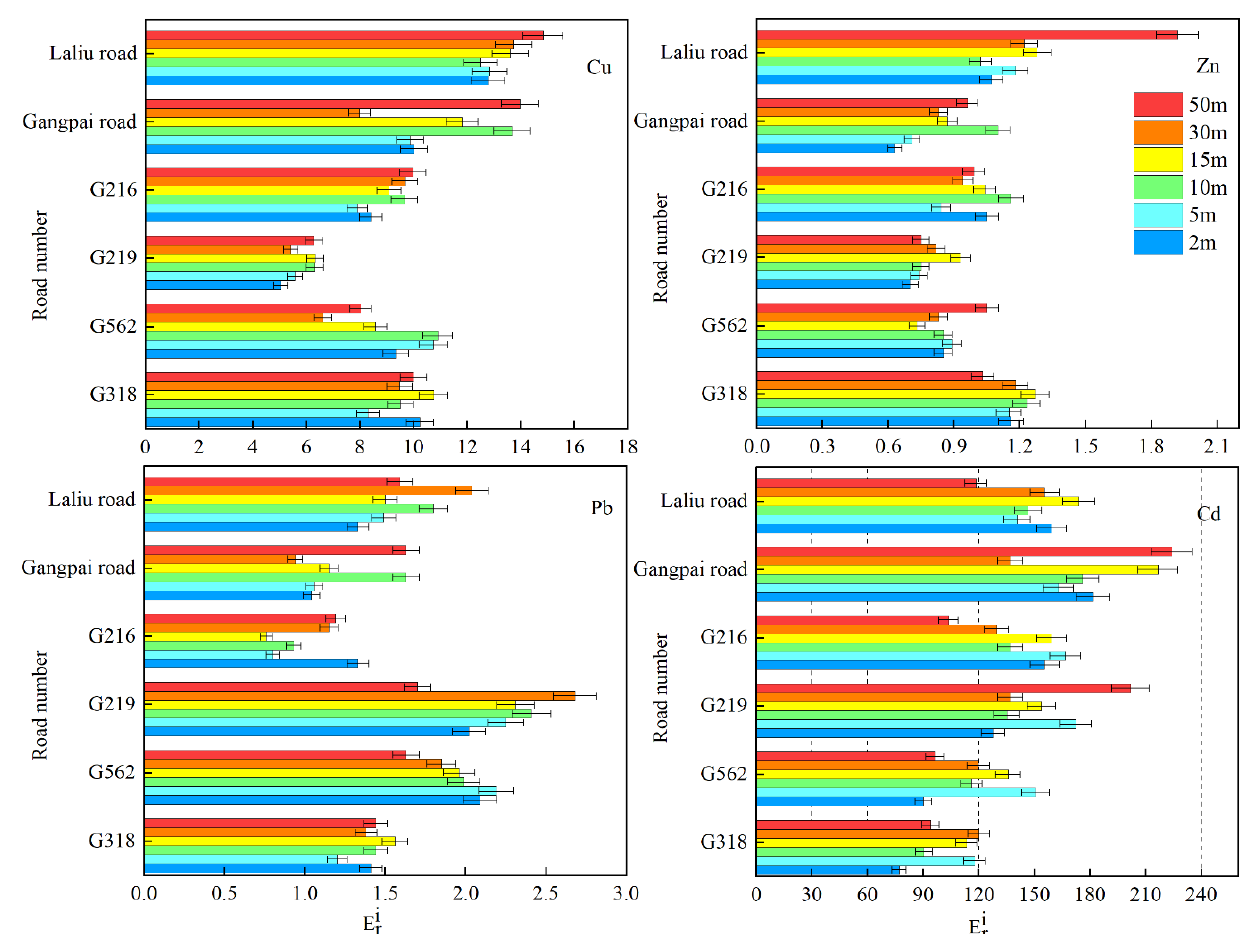
Figure 6. Average E i r values representing soil heavy metal pollution at different distances from each road.